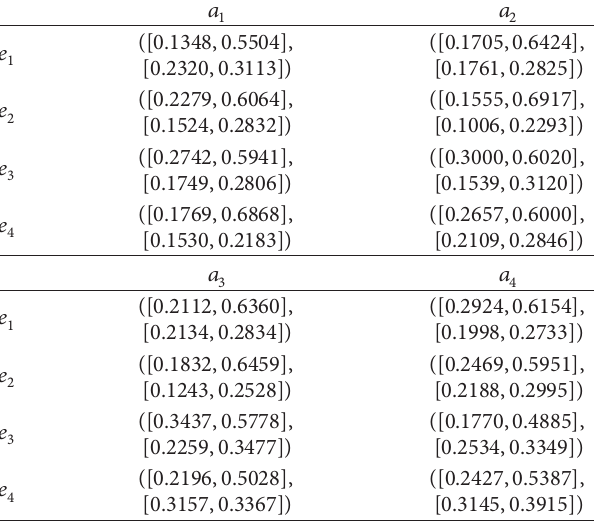
Table 2: Interval-valued intuitionistic fuzzy decision matrix of 𝐷 . 𝑎